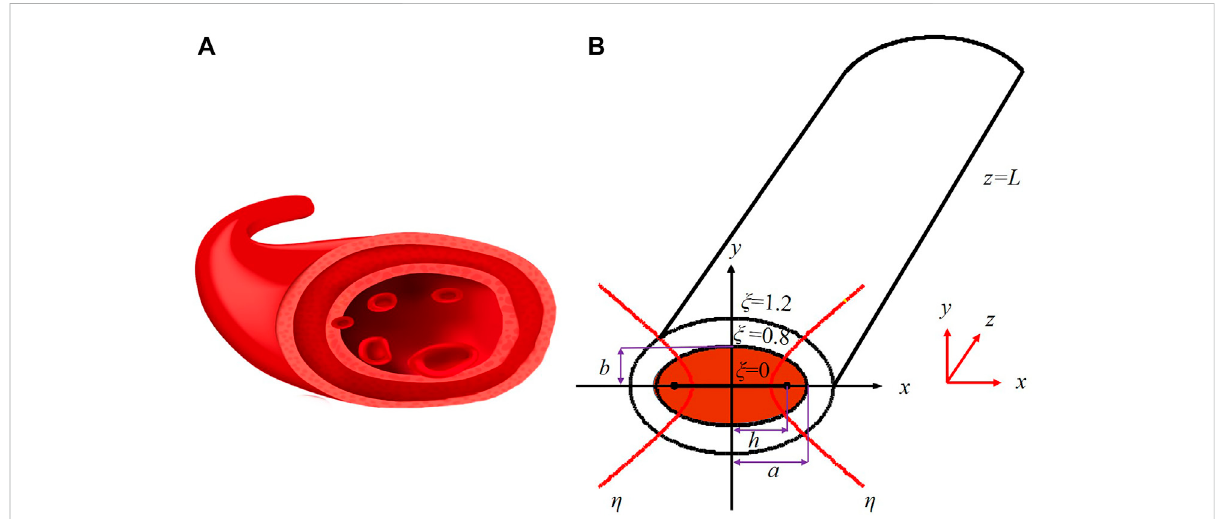
FIGURE 1 Illustration of the model for deriving the analytic solution. (A) Illustration of a blood vessel. (B) The corresponding model of the in fi nite long fl uidic elliptic cylinder in the elliptical coordinates. The semi-major and semi-minor axis of the elliptic cylinder is a and b , respectively. In the z -direction, L is in fi nite. The half focal distance (the focal radius) is denoted by h